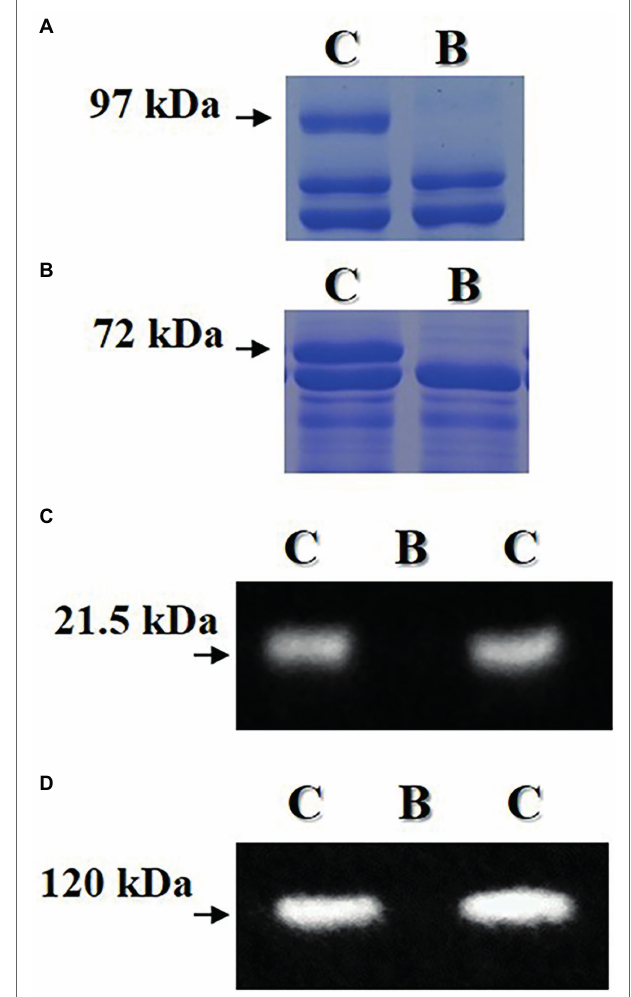
FIGURE 4 | Confirmation of absence of lipoxygenase (A) , 7S α ′ subunit (B) , KTI (C) , and lectin (D) proteins in mature seed of the breeding line (B) with the penta null genotype ( lox1lox2lox3 / lox1lox2lox3 - ti / ti - le / le - cgy 1/ cgy1 - rs2 / rs2 ). Arrows indicate lipoxygenase protein of 97 kDa, 7S α ′ subunit protein of 72 kDa, KTI protein of 21.5 kDa and lectin protein of 120 kDa. C: “Daewonkong” ( Lox1Lox2Lox3 / Lox1Lox2Lox3 - Ti / Ti - Le / Le - Cgy1 / Cgy1-Rs2/ Rs2 genotype.